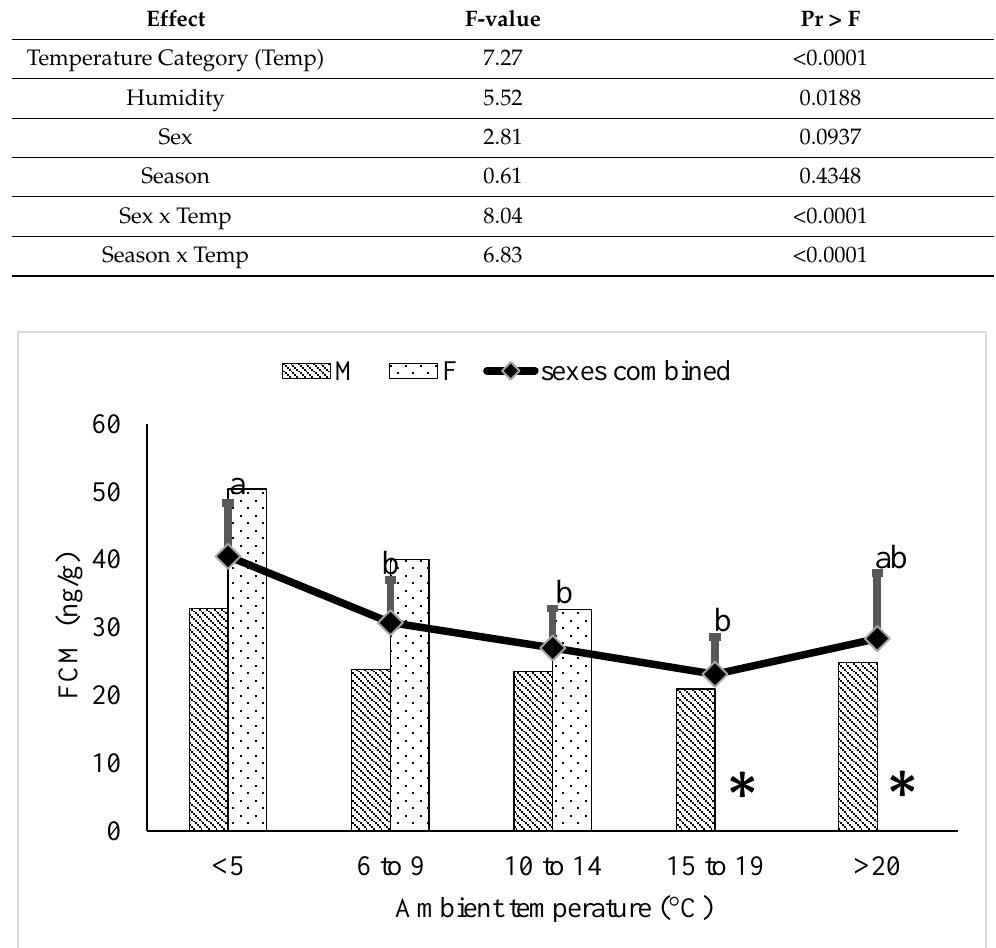
Figure 4. Back-transformed LSMeans ± SEM for fecal cortisol metabolite (FCM) concentrations (ng/g dry feces) within different ambient temperature categories for adult (6–17 years) polar bears during the breeding season (February to April) (N samples = 1007). Different subscripts represent differences between temperature categories ( p < 0.05). Columns represent sex-specific back-transformed LSMeans for each temperature category. Sex-specific means were not graphed for the females at higher temperature categories (*) because fewer than 3 females experienced temperatures in each of these categories during the breeding season.